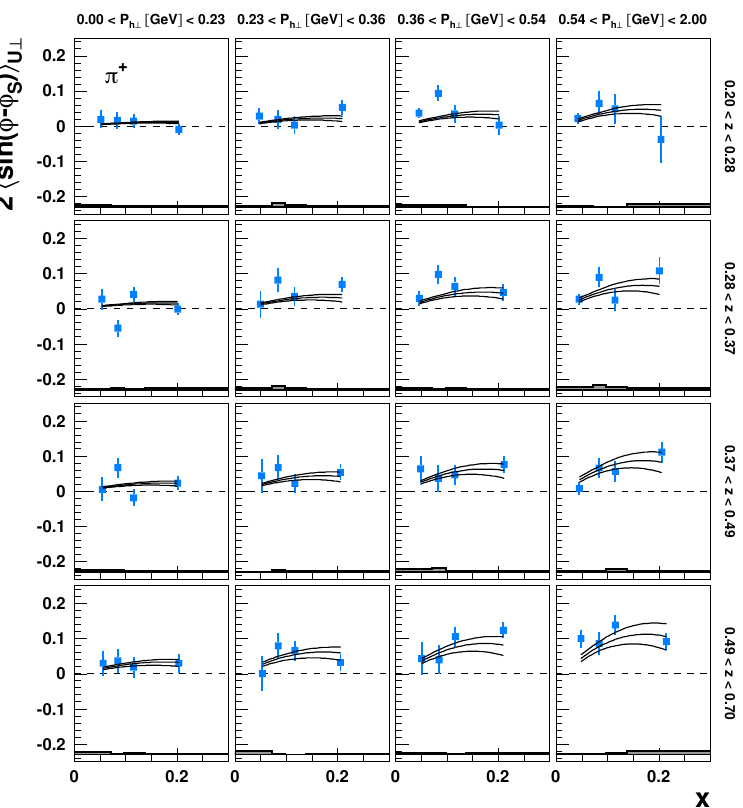
Figure 15 . Sivers SFA for π + extracted simultaneously in bins of x , z , and P h ⊥ , presented as a function of x . Systematic uncertainties are given as bands, not including the additional scale uncertainty of 7.3% due to the precision of the target-polarization determination. Overlaid is a phenomenological fit [152] to previously available data, with the three lines corresponding to the central value of the fit and the fit